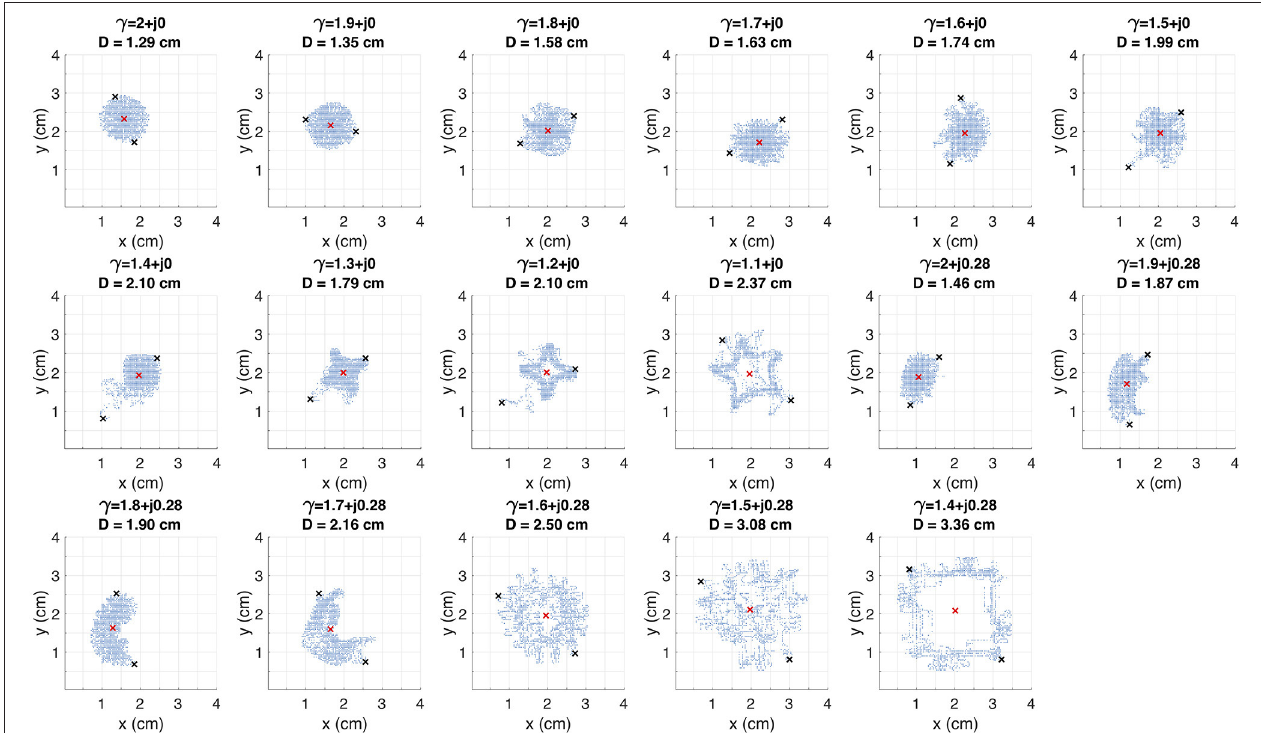
FIGURE 8 | Trajectory of the rotor tip within the spatial plane ( x , y ) for several test values of γ . The red mark indicates the rotor core. The D value corresponds to the distance between the black marks. These marks depict the farthest points within the